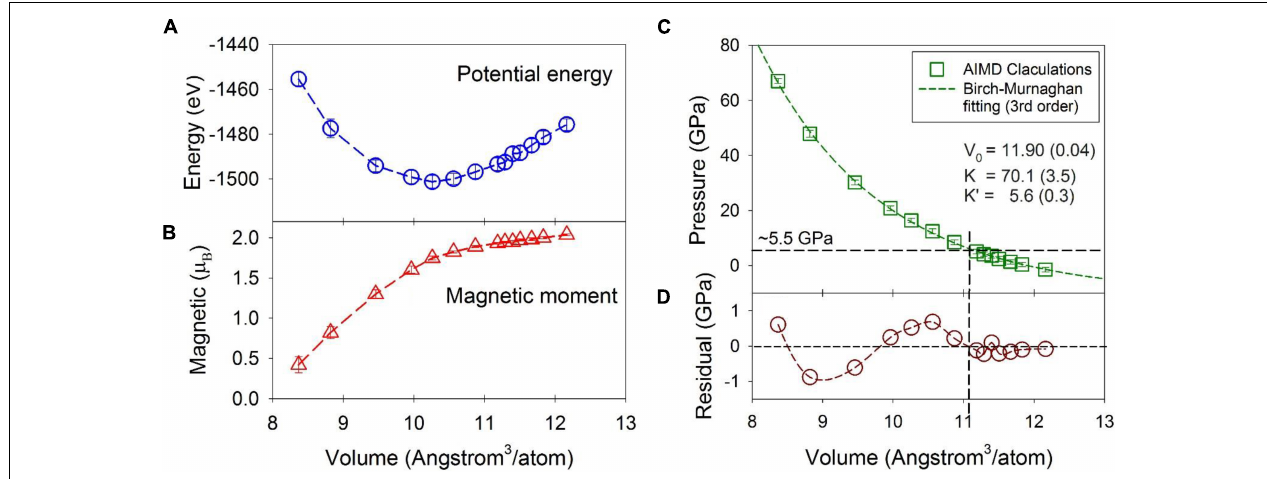
FIGURE 1 | Statistical averages from the first-principles molecular dynamics simulations as a function of volume (Å 3 /atom) at 1673 K. (A) System potential energy (eV). (B) Magnetic moment per Fe or Ni atom ( µ B ). (C) Pressure and the fitted curve from the third order Birch-Murnaghan equation. (D) The residual of the fitting. The average and standard deviation were calculated over the MD simulation at each volume. Error bars denote one standard deviation of the data and most are within the symbol size. The actual errors are about one magnitude smaller than the standard deviation. Dashed lines are intended to guide the eye.